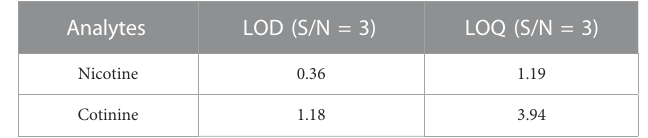
corresponding to the loss CH 3 -NH 2 (calculated 31.0422 Da) from 98.0600 is the fragment ions of by loss of pyridine (calculated 79.0422 Da) from protonated cotinine. These fragment ions were further con fi rmed by the isotopic cotinine-d3, as shown in Figure 2D. There is base peak of pronated cotinine-d3 (M + H) + at m/z 180.1212. Because three H/D sites are in the pyrrolidine cycle. The ions at m/z 146.0602 is produced by the loss of CD 3 -NH 2 from protonated cotinine. The peak at m/z 80.0500), while the ions at m/z 101.0788 is produced from protonated cotinine-d3 by loss of pyridine, as shown inset of Figure 2C. These data clearly show the detection and identi fi cation of nicotine and cotinine by high-resolution and MS/